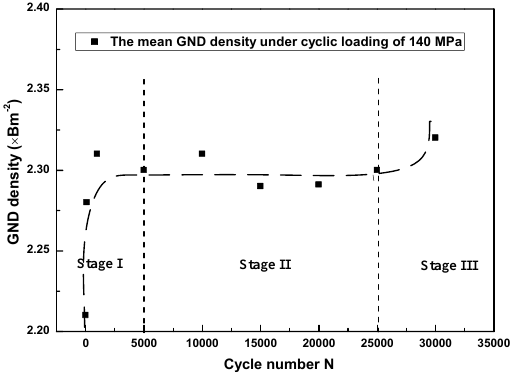
Figure 7. The mean GND density distributions under 140 MPa.